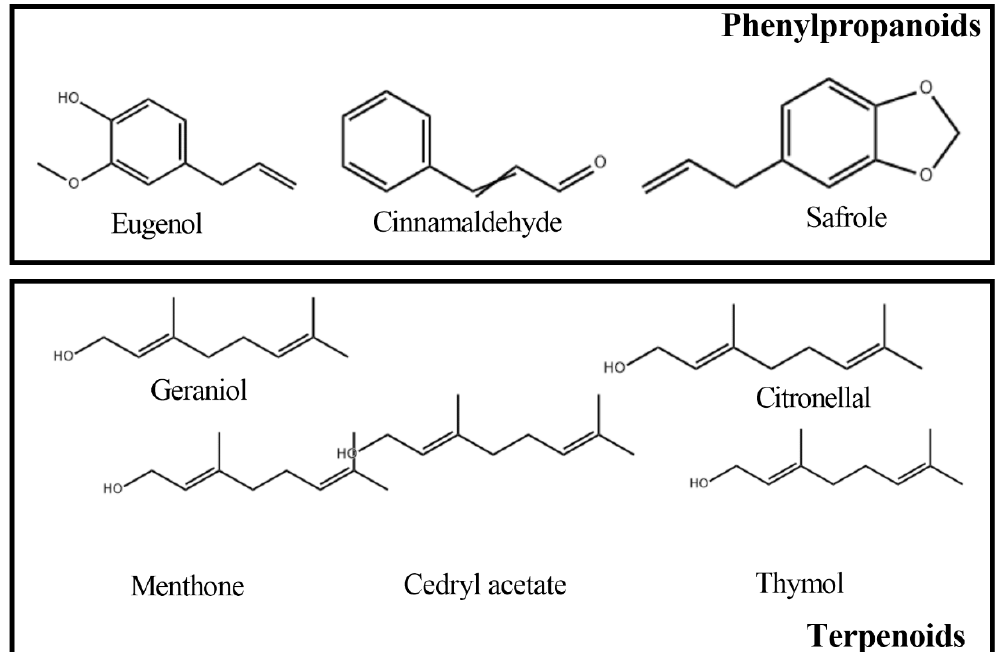
Figure 1. Chemical structural formulas of some essential oils.